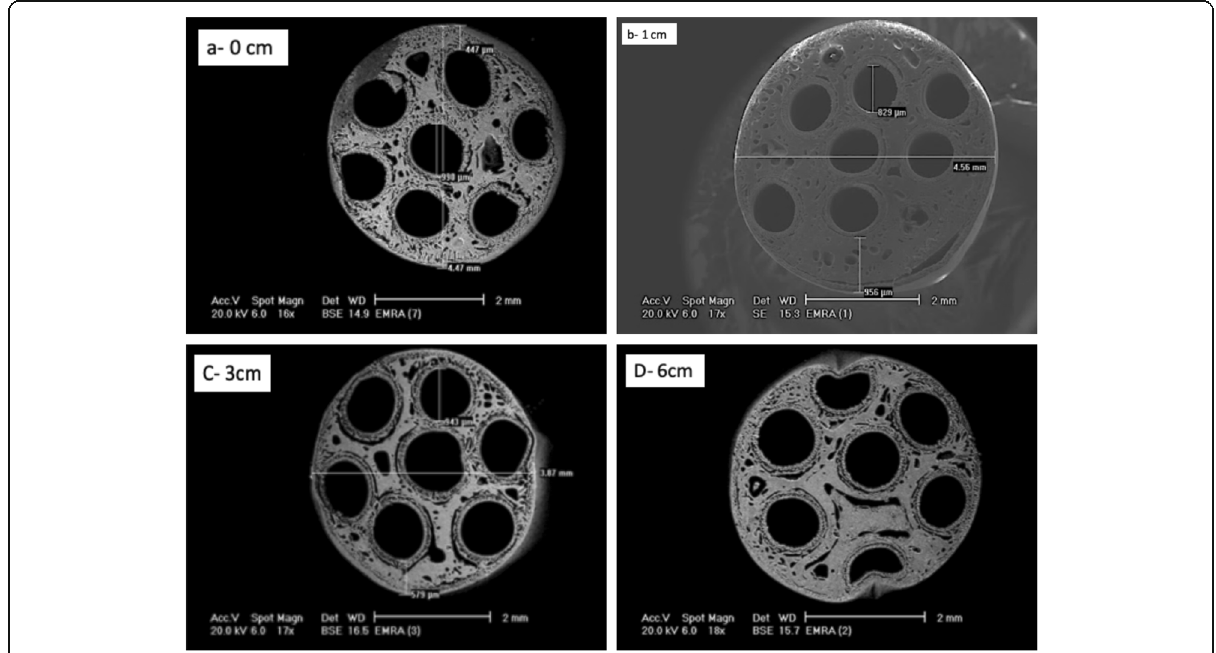
Fig. 13 Effect of air gap distance on (7 BHF)